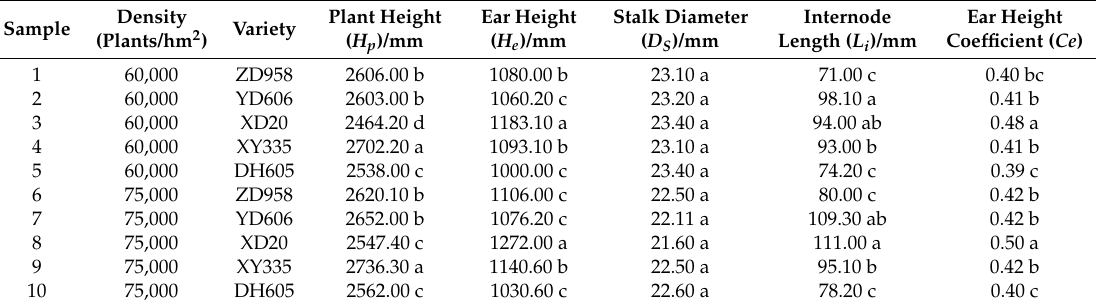
Figure 1. Five varieties of corn grown in the Science and Education Farm of Henan Agriculture University, Zhengzhou. Table 1. Agronomic traits obtained from five varieties of corn with two planting densities .